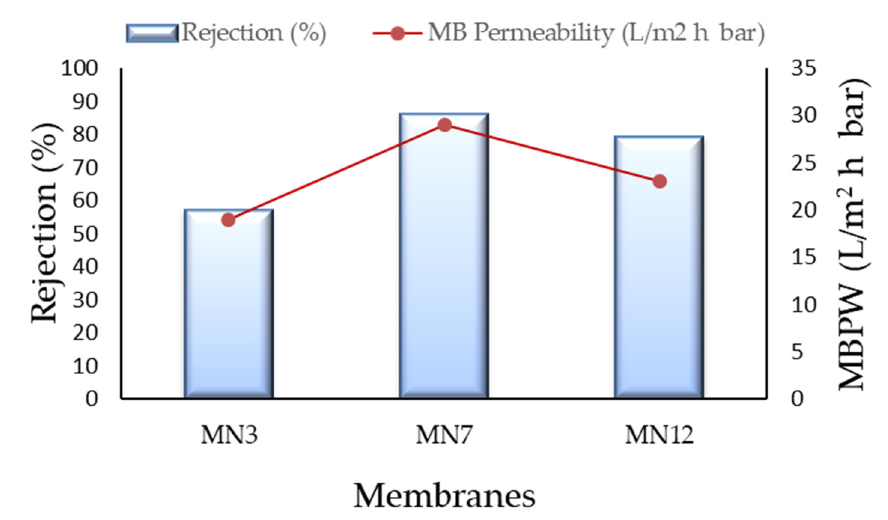
Figure 11. Filtration tests results with MB dye for the investigated membranes.